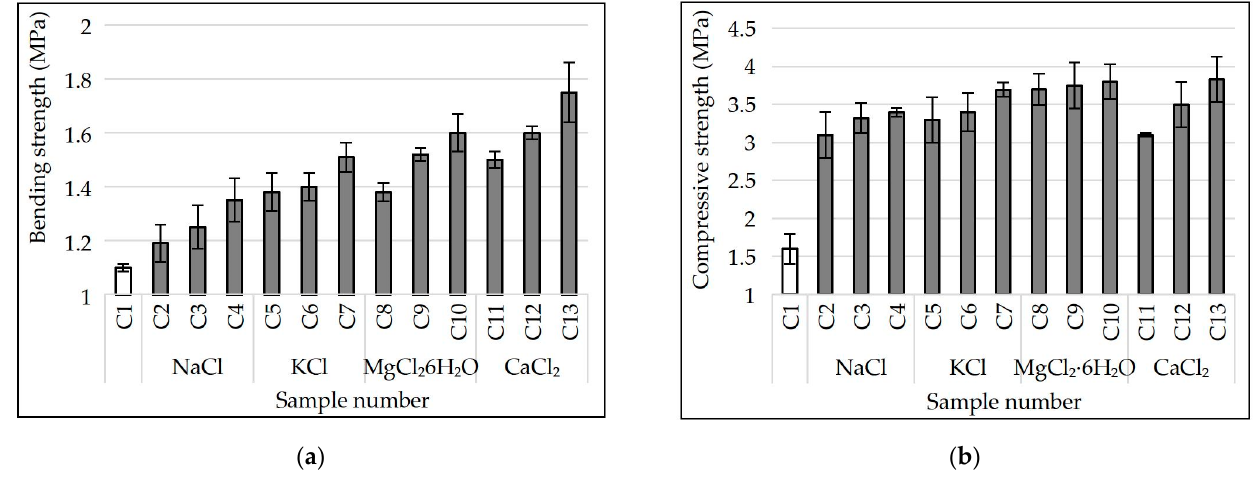
Figure 6. Bending ( a ) and compressive ( b ) strength of